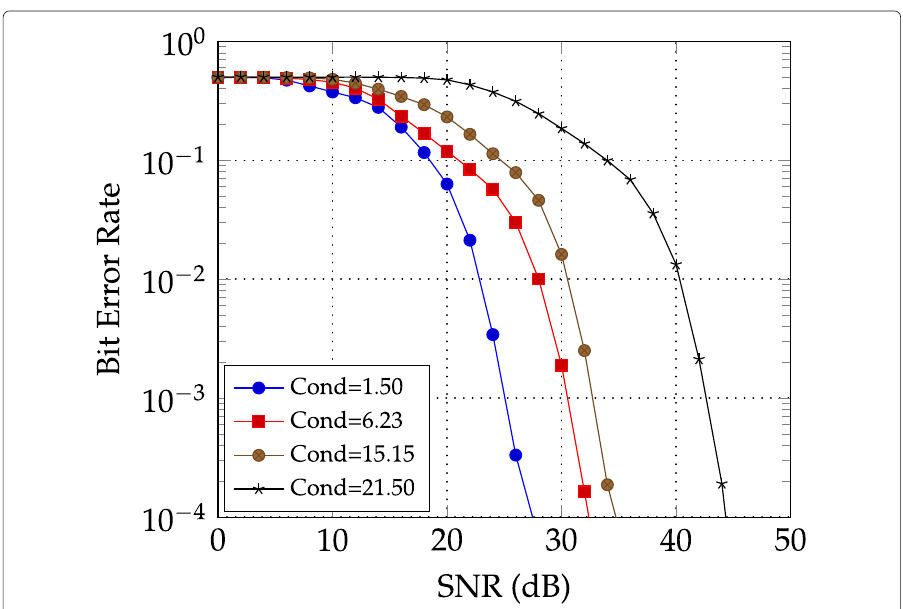
Fig. 3 Effect of the postcoder’s condition number on the BER vs SNR—4 × 4 MIMO channel